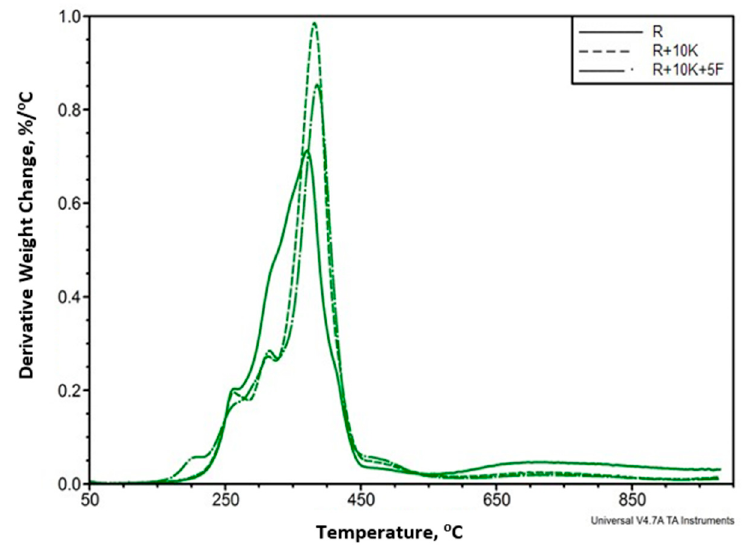
Figure 5. The examples of thermogravimetric analysis (TGA) curves for foam sample R.